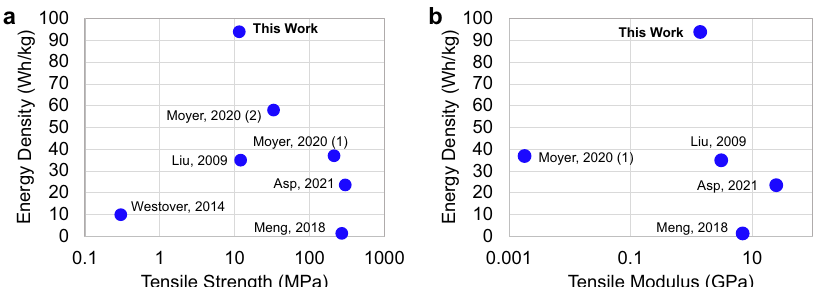
Fig. 7 Multifunctional performance graph comparing the mechanical and energy storage performance of the SCB to work reported in the literature. Additional details are provided in Supplementary Table